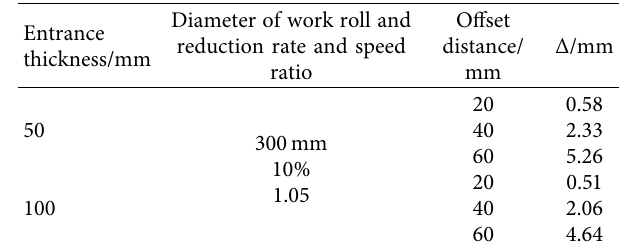
Table 3: Compensation value for the initial finite element model.